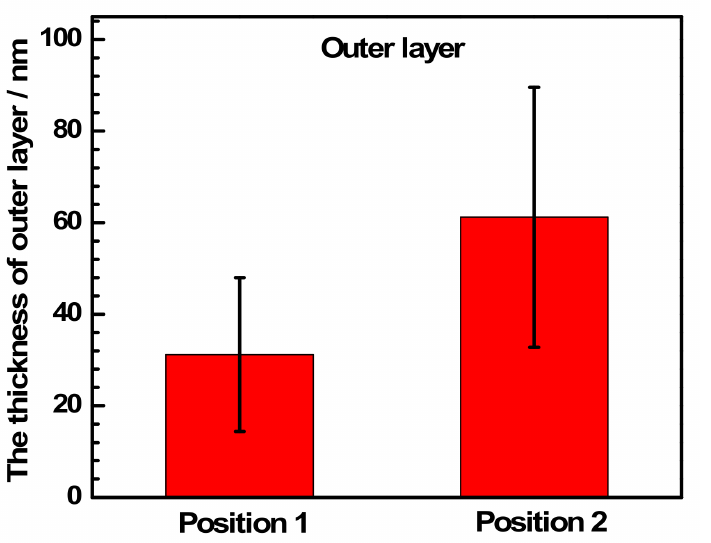
Figure 10. The average thickness of the outer layer of fouling at different positions of the SG tube according to Figure 7a,b, and the error bar indicates the standard